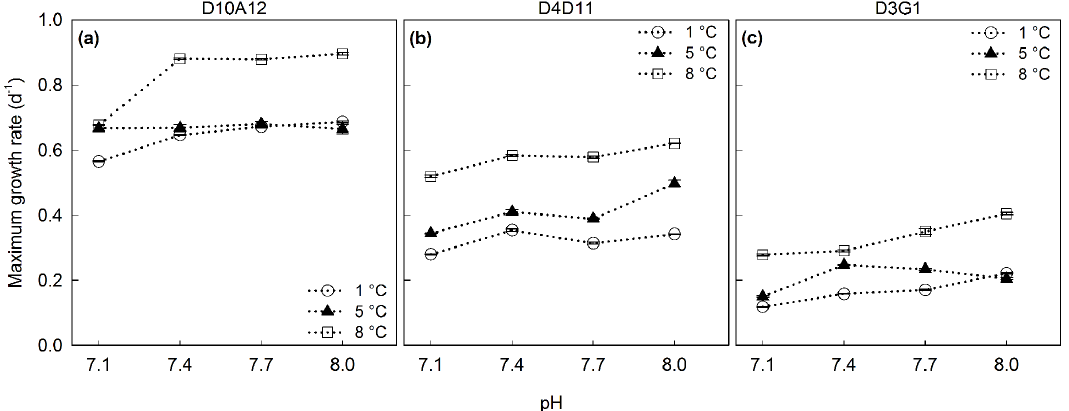
Figure 1. The mean maximum growth rates (d − 1 ) for strains (a) D10A12, (b) D4D11, and (c) D3G1 cultured at temperatures of 1, 5 and 8 ◦ C, and four different pH treatments. Error bars represent ± SD. Note that the data are categorical and the dotted lines serve to show the trend.